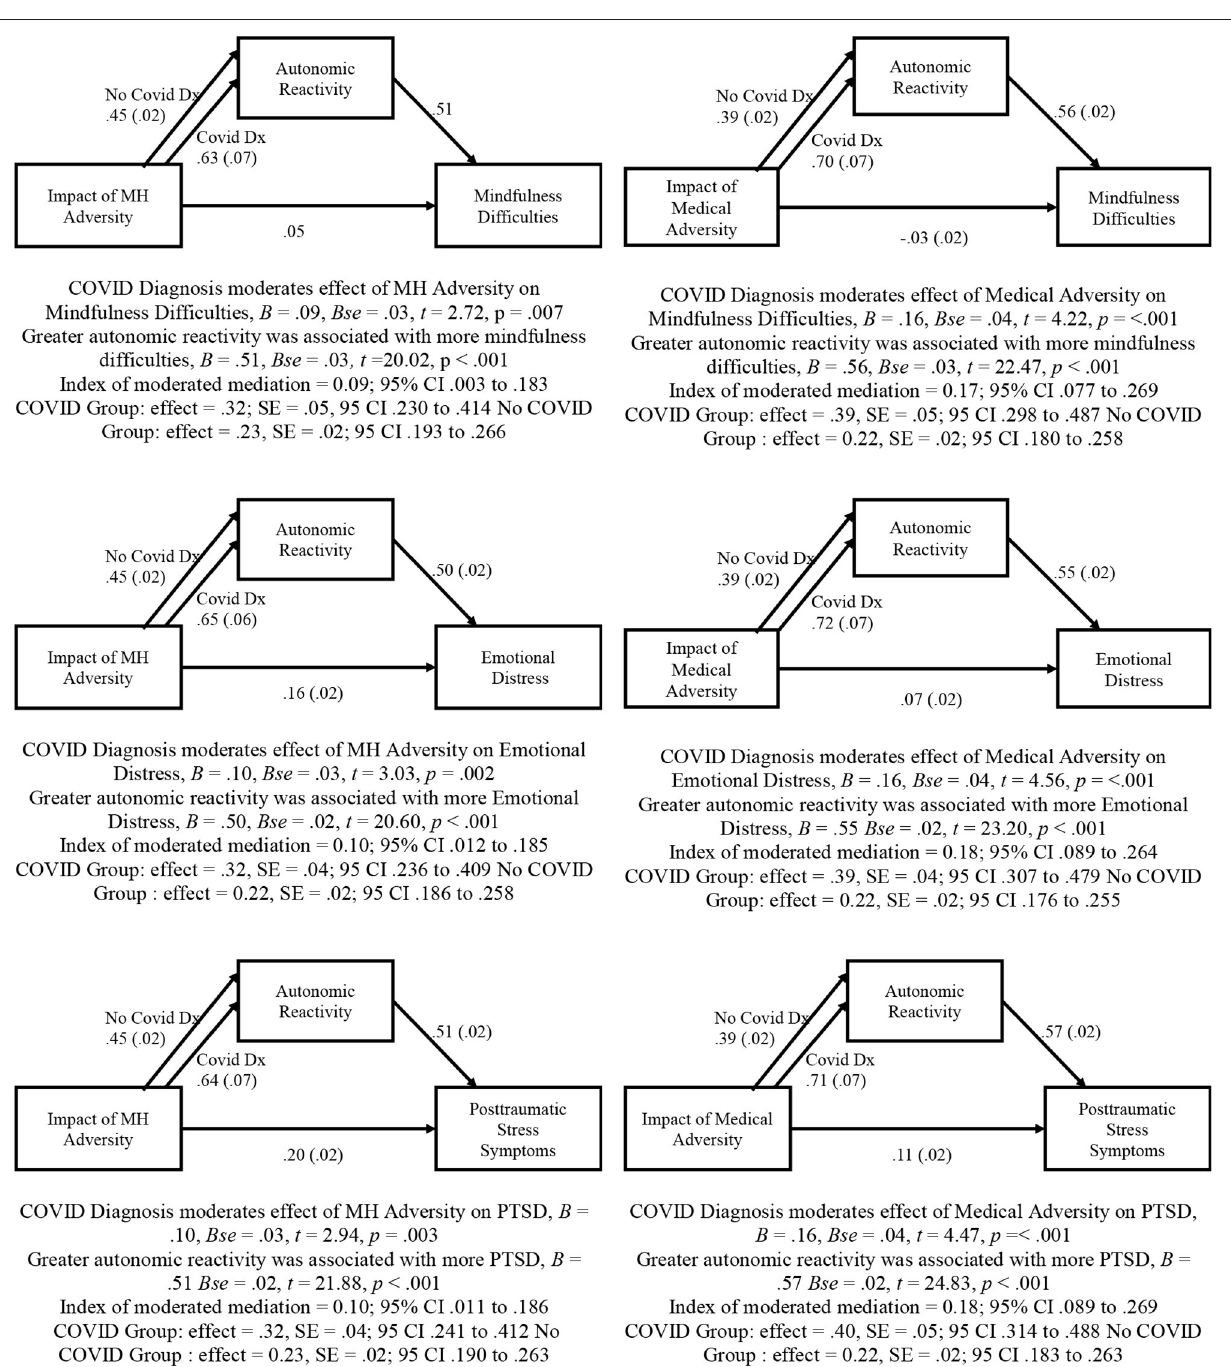
FIGURE 2 | Moderated mediation models testing relationship among prior adversity, current autonomic reactivity, and current mental health difficulties.